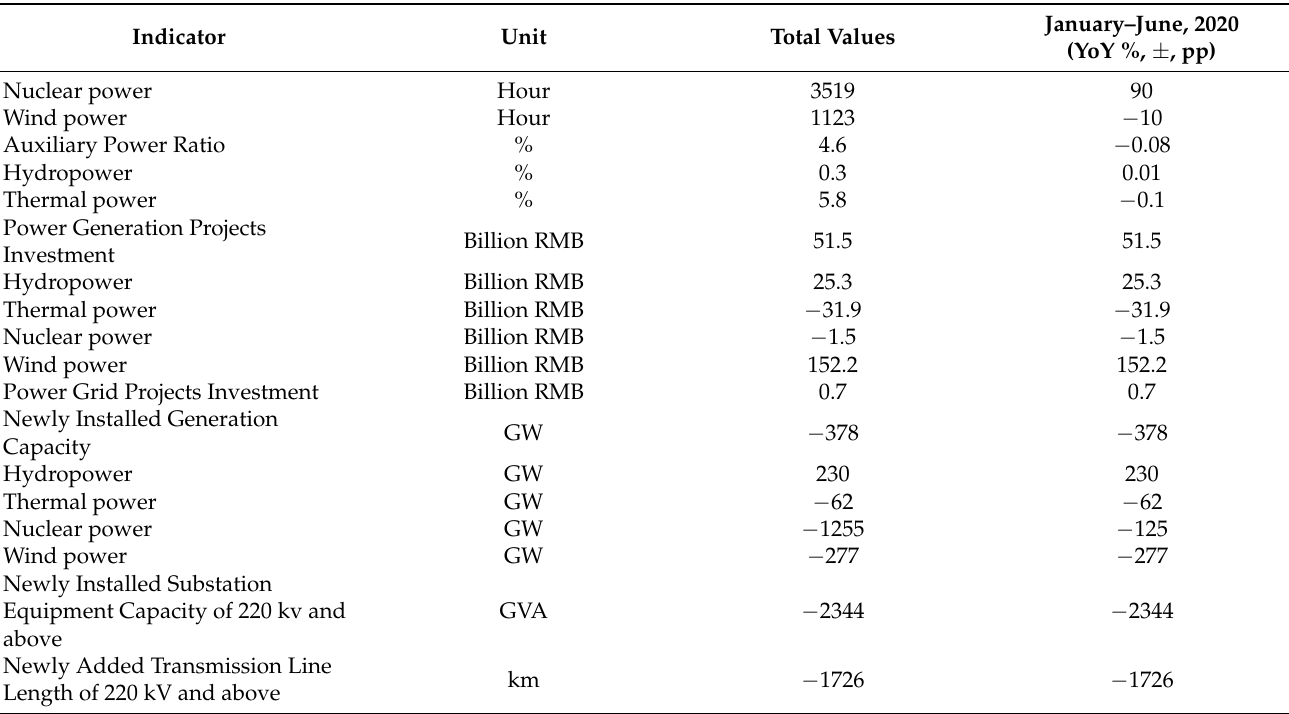
Figure 9. Electricity consumption and its growth rate by month in 2019 and 2020 [37]. Source: CEC (2020) Statistics of Electricity Consumption. All rights reserved. Sector-wise, electricity consumption for the primary industry was 37.3 TWh from January to June, an increase of 8.2% year-on-year; that for the secondary industry was 2251.0 TWh, a decrease of 2.5% year-on-year; for the tertiary industry, it was 533.3 TWh, a decrease of 4.0%; and that for residential use was 533.1 TWh, an increase of 6.6% year- on-year as illustrated in Figure 10.